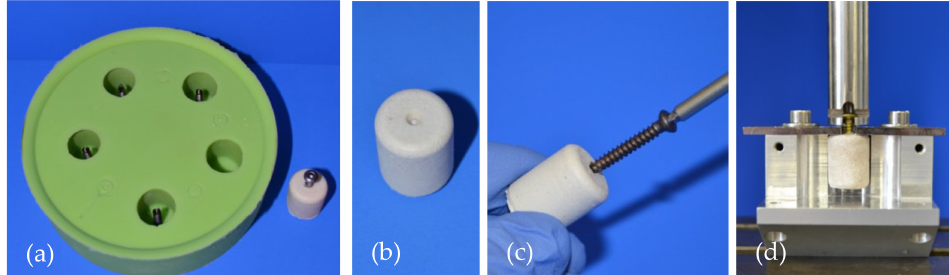
Figure 2. Specimen preparation and test set-up for the screw pullout tests. ( a ) Silicon mold with screws at the bottom for the preparation of embedded screw specimens. ( b ) Specimen for the groups with drilled screws. The central notch served as a marker for subsequent drilling and tapping. ( c ) Screw insertion into a specimen made of MPC_25 after 15 min of hardening. ( d ) Screw pullout testing in a custom-made device where the screw head was gripped by a holder attached to the crosshead of the materials testing